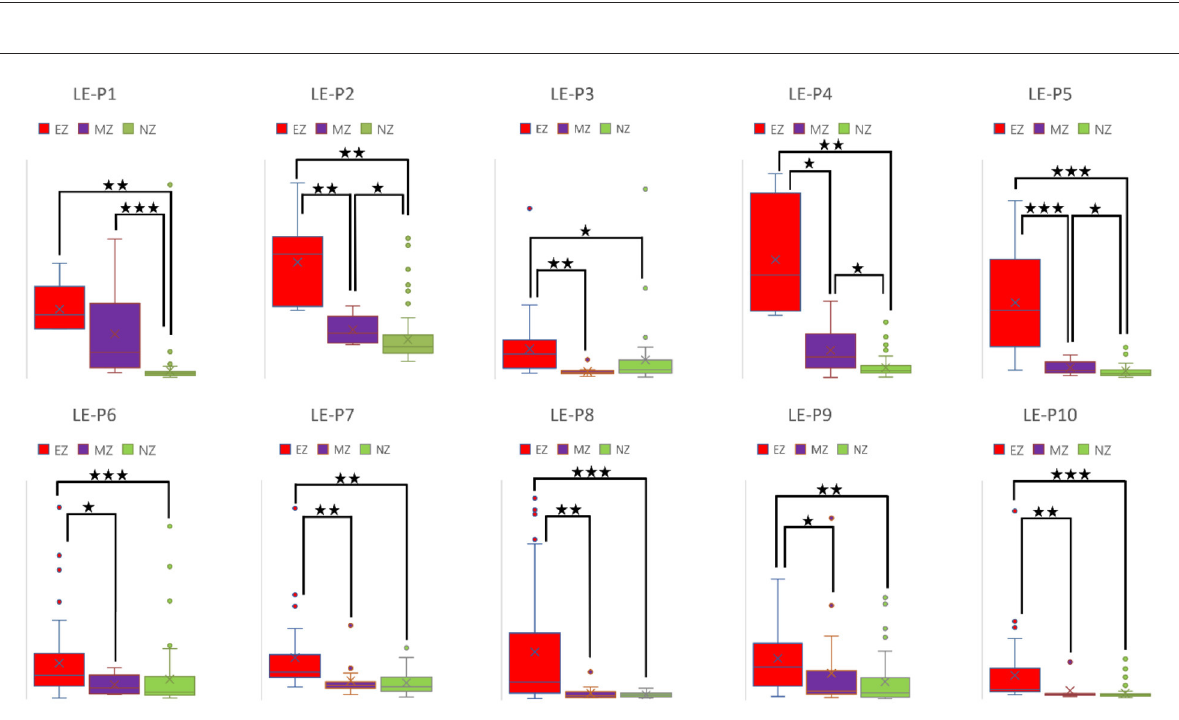
FIGURE4 Box plot of LE of all ten patients for EZ, MZ, and NZ (P1 represents patient 1; ⋆ represents p < 0.05 with EZ > MZ, EZ > NZ, or MZ > NZ; ⋆⋆ represents p < 0.001 with EZ > MZ, EZ > NZ, or MZ > NZ; ⋆⋆⋆ represents p < 0.00001 with EZ > MZ, EZ > NZ, or MZ > NZ; Mann–Whitney U -test [two–tailed]). LE, local efficiency; EZ, epileptogenic zone; MZ, margin zone; NZ, normal